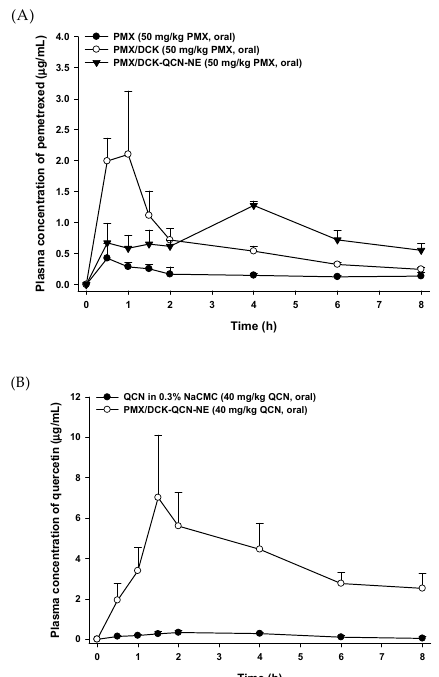
Figure 5. The mean plasma concentration-time profiles of PMX and QCN after single oral administration of ( A ) PMX (50 mg/kg), PMX/DCK (equivalent to 50 mg/kg PMX), or PMX/DCK-QCN-NE (equivalent to 50 mg/kg PMX) and ( B ) QCN in 0.3% NaCMC (40 mg/kg) or PMX/DCK-QCN-NE (equivalent to 50 mg/kg PMX) to rats. Values are expressed as mean ± standard deviation ( n = 4).